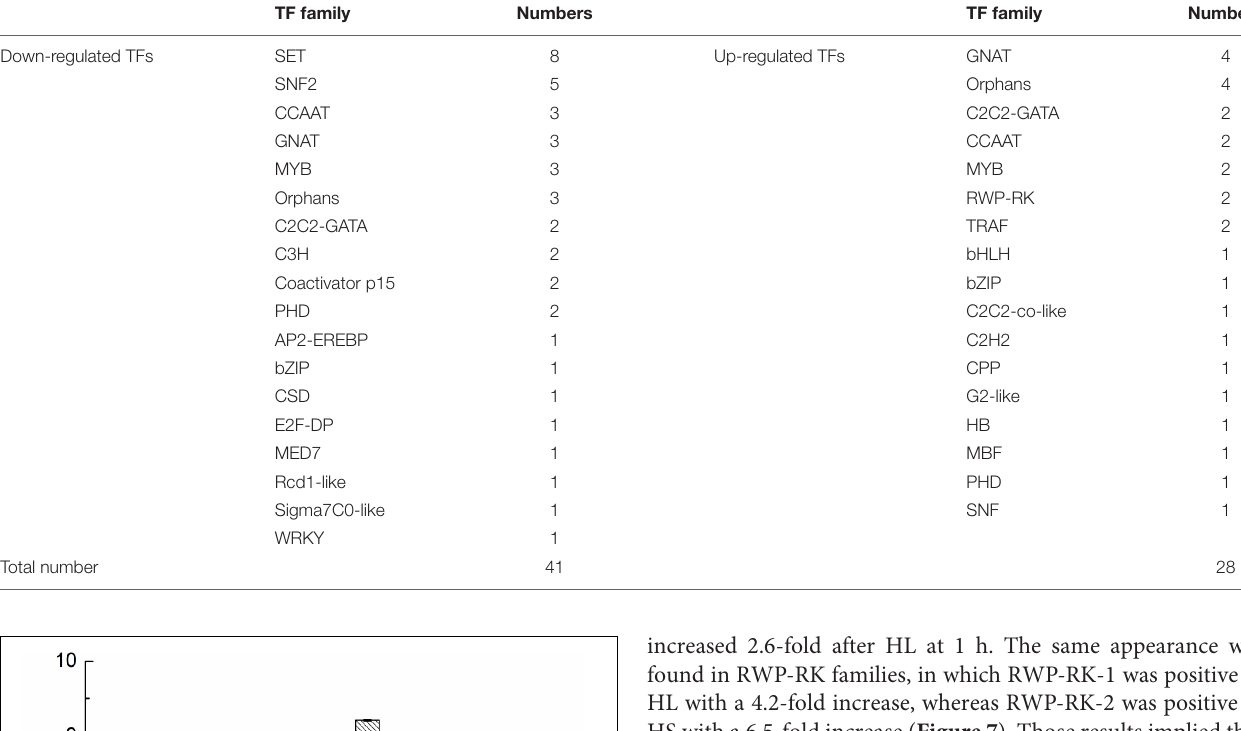
TABLE 4 | Differentially expressed transcription factors (DETFs) and their classification.